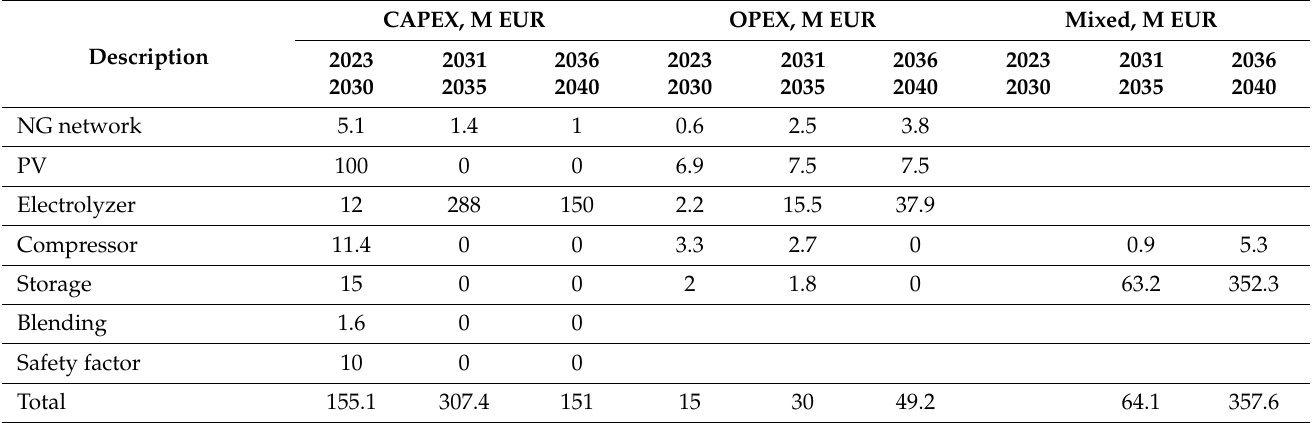
Table 6. Cost analysis